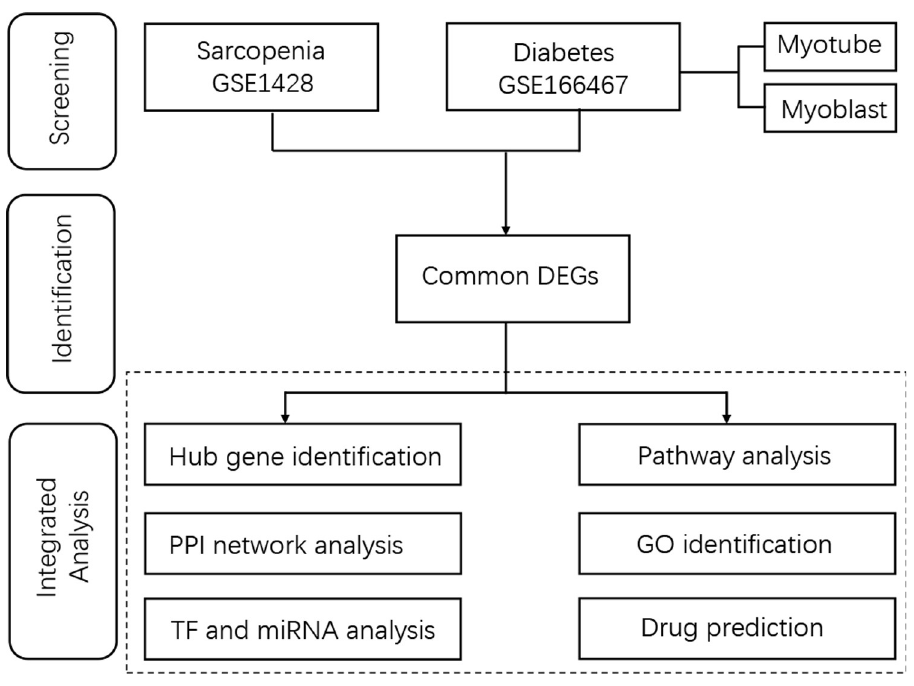
Fig 1. Workflow of the whole study. DEGs, differentially expressed genes; GO, Gene Ontology; PPI, protein-protein interaction; TF, transcription factor.